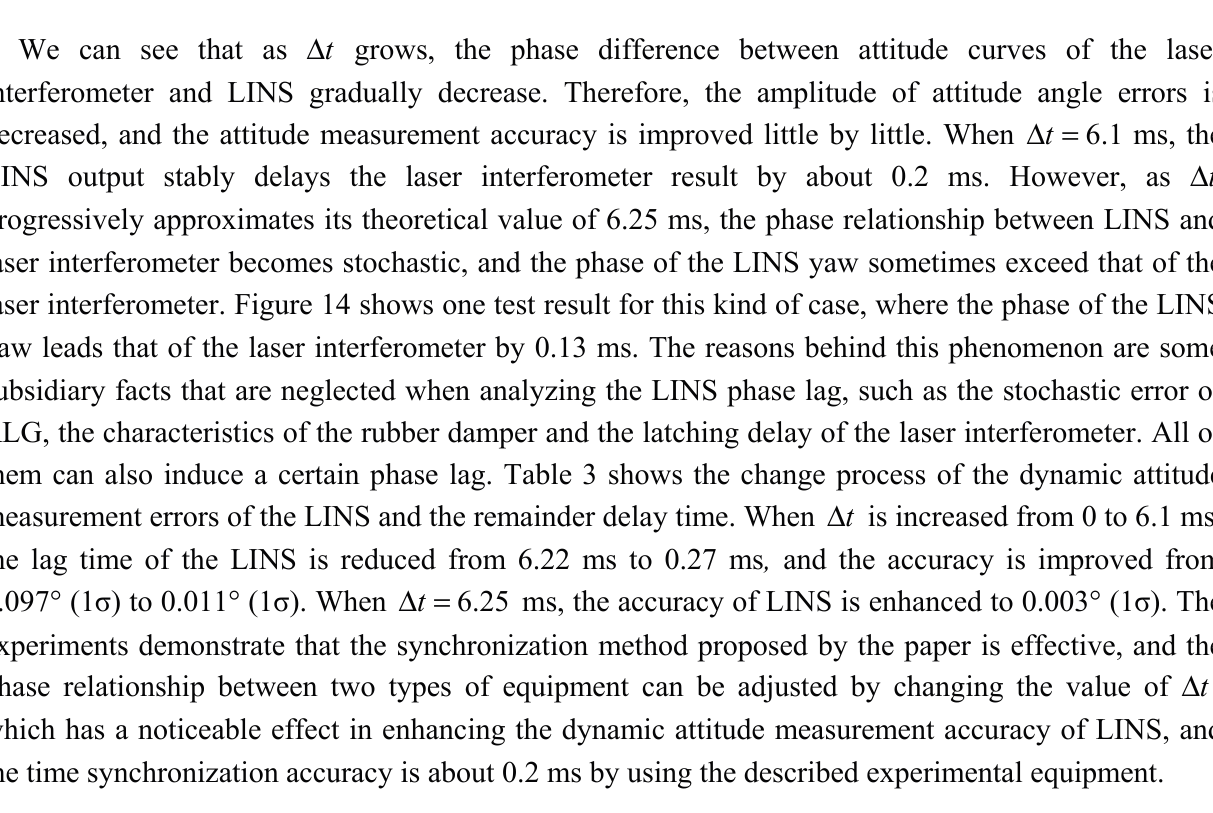
wobbling test results. ( a ) First 12s wobbling test; ( b ) Phase relationship between turntable and LINS; ( c ) Error